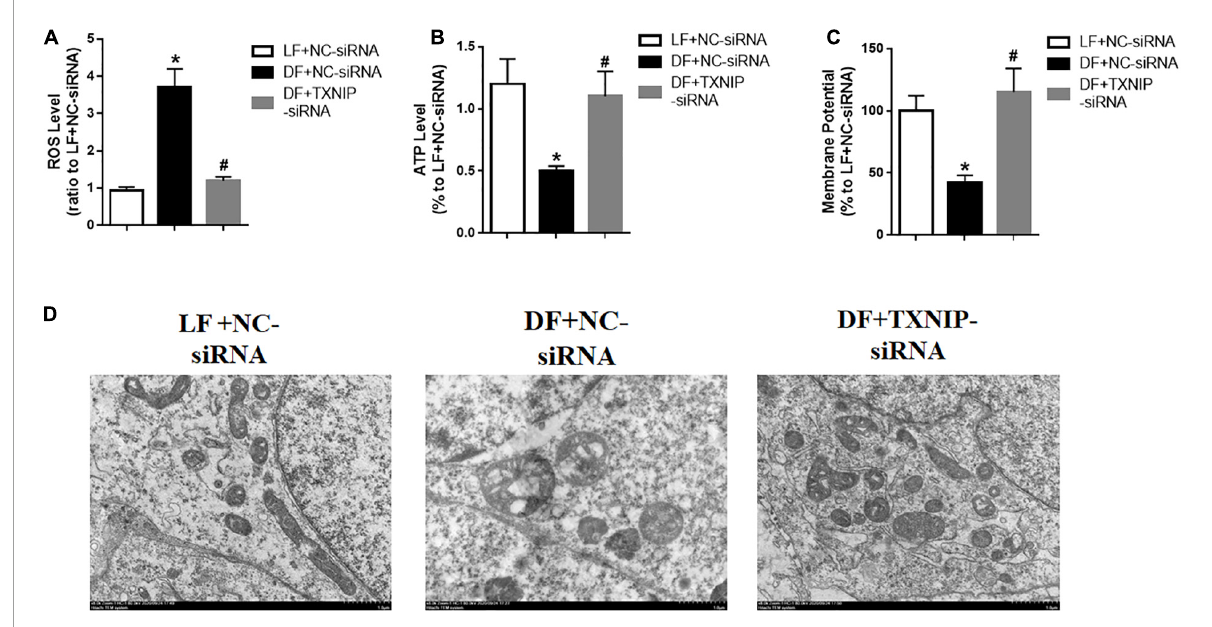
FIGURE4 Disturbed flow induced endothelial mitochondrial dysfunction by regulating TXNIP expression. (A) Reactive oxygen species (ROS) level, (B) Mitochondrial ATP level, (C) Mitochondrial membrane potential, in the LF + NC-siRNA, DF + NC-siRNA, and DF + TXNIP-siRNA treated groups. (D) Representative image of mitochondrial morphologies with transmission electron microscopy of HUVECs, respectively. Results are shown as mean ± SD. N = 5/group. * P < 0.05 vs. LF + NC-siRNA, # P < 0.05 vs. DF +